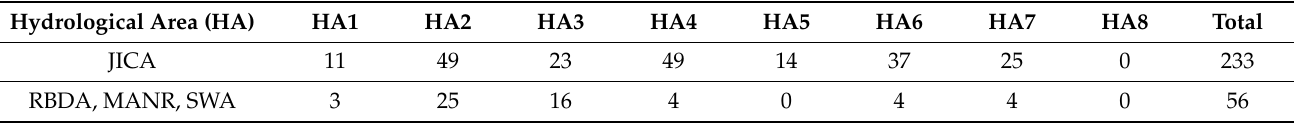
Table 2. Proposed large and medium dams for irrigation and water supply towards 2020 in 1995 NWRDMP. Hydrological Area